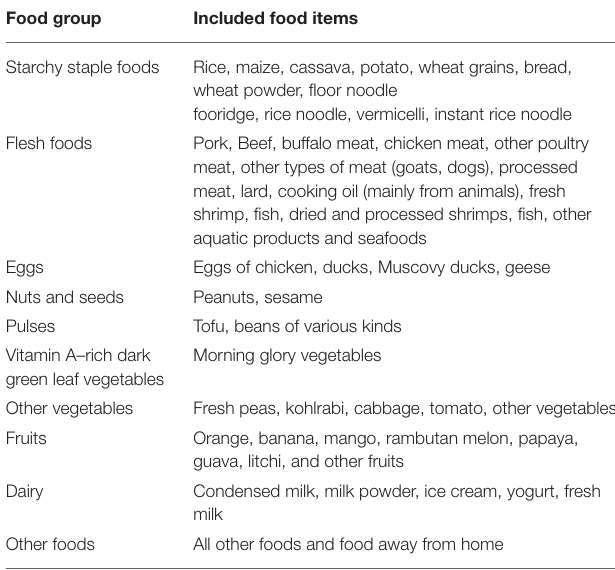
TABLE 1 | Description of food groups from the VHLSS questionnaires. Food group Included food